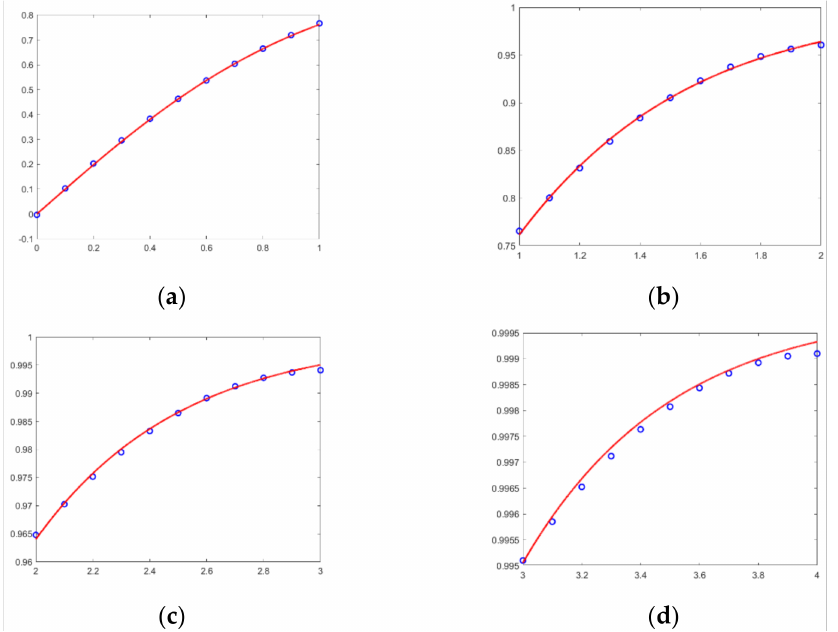
Figure 5. The images of the fitting effect of these functions. ( a ) Numerical interval [0, 1]. ( b ) Numerical interval (1, 2]. ( c ) Numerical interval (2, 3]. ( d ) Numerical interval (3,